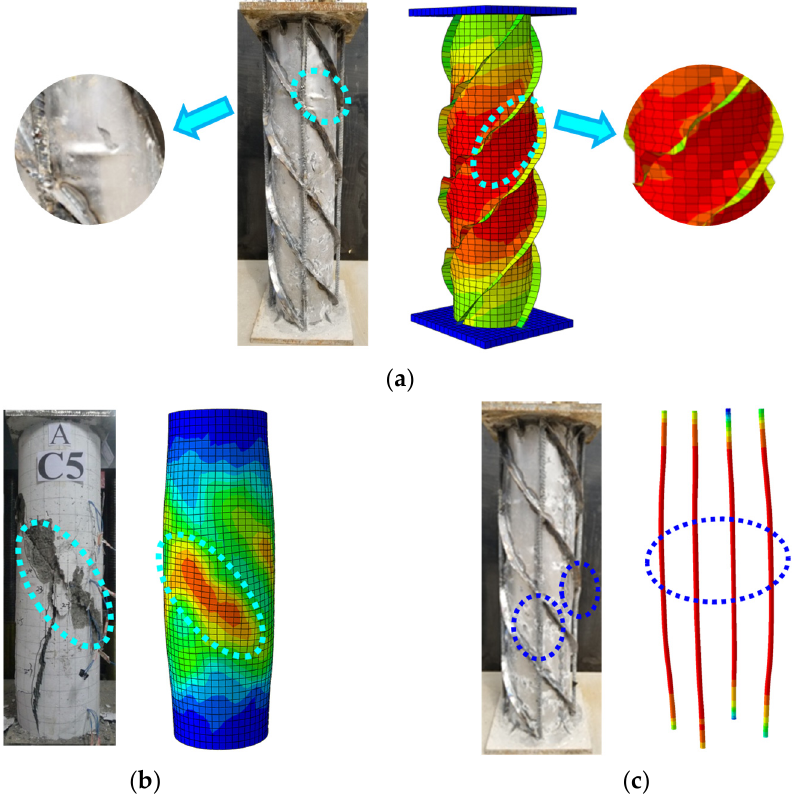
Figure 11. Comparison of test phenomena and simulations. ( a ) Spiral ribbed steel pipes ( b ) External concrete ( c ) Steel reinforcement.